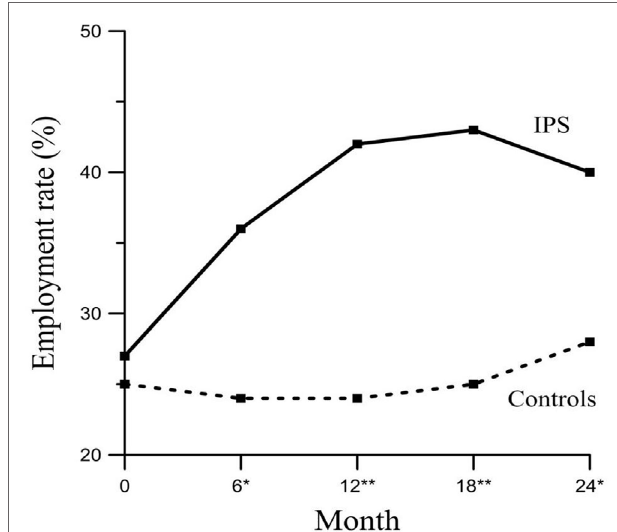
FigUre 2 | employment rates of competitive employment for iPs and control group throughout the whole 2-year period (lOcF) including jobs that had been held already at the beginning of the study . Chi-Quadrat-test; * p < 0.05; ** p < 0.01. The total numbers of jobs during each time of measurement.